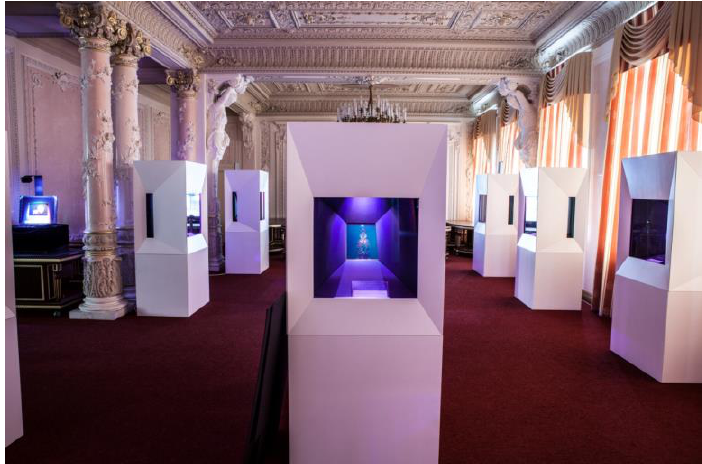
Figure 10 . Photos of the recorded OptoClones TM of the Coronation Imperial Easter Egg ( Left ) and the Rosebud Imperial Egg ( Right ) ( © 2015 HiH).